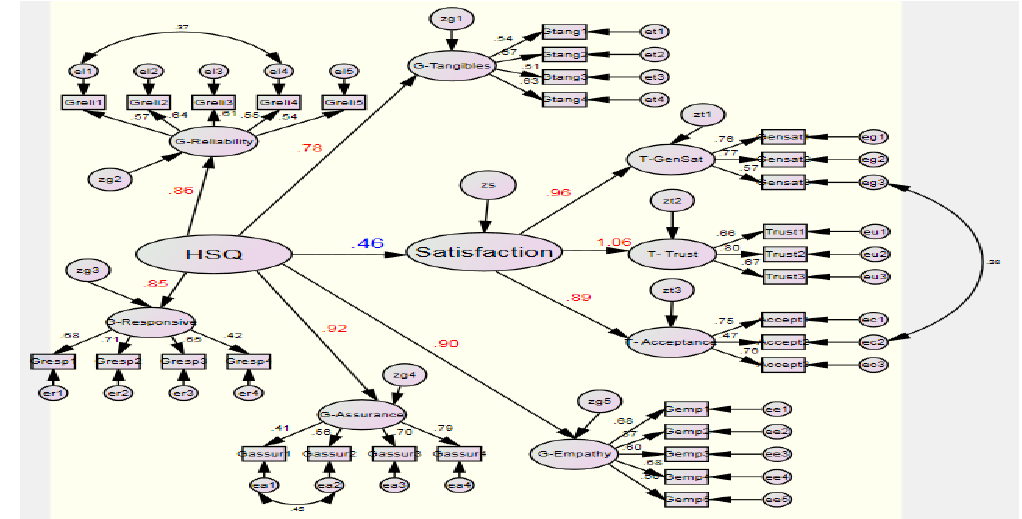
Fig. 5. The structural model and the standardized factor loading